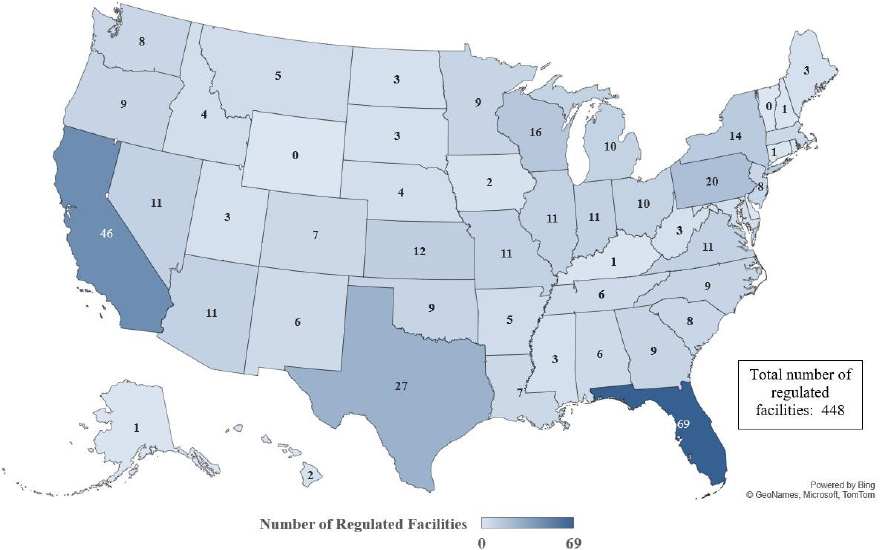
Figure 5. Total number of big cats in federally regulated facilities in each state.